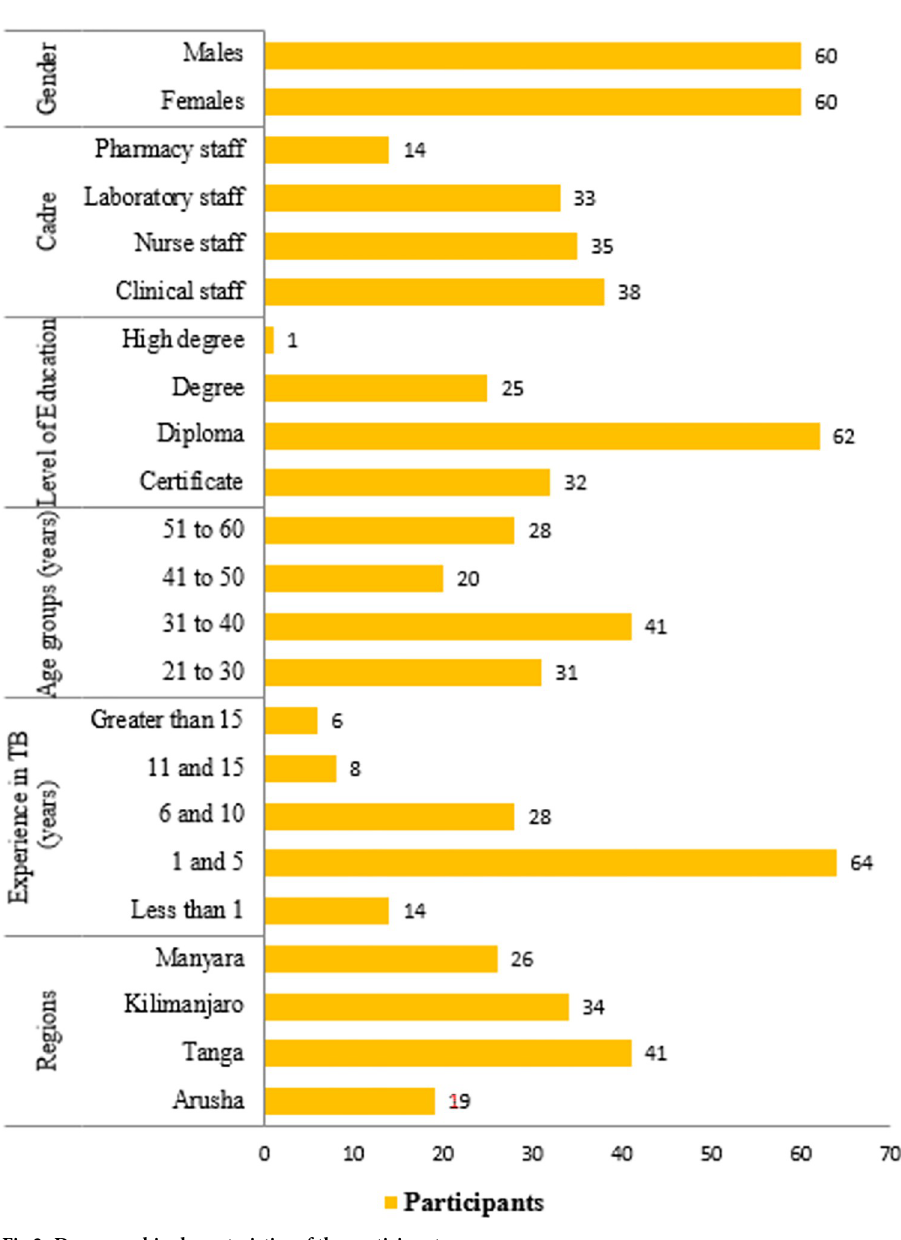
Fig 2. Demographic characteristics of the participants.